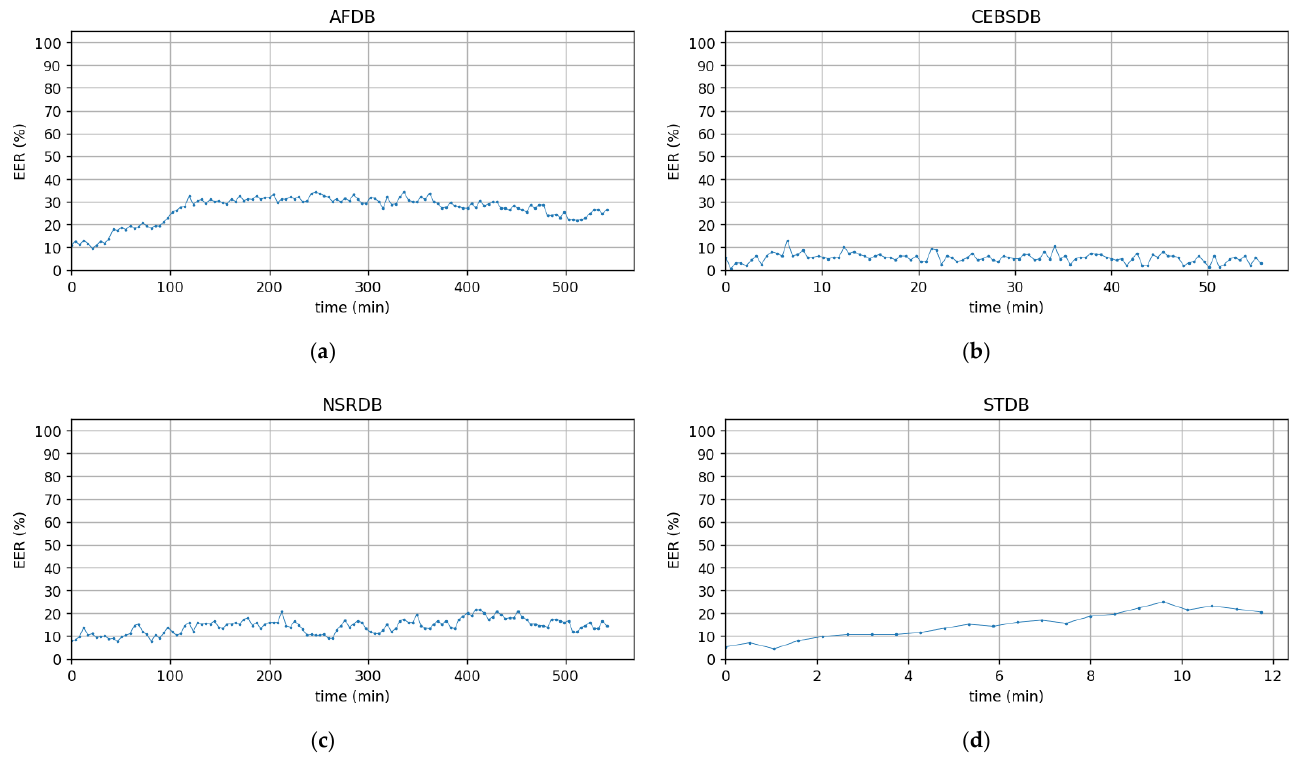
Figure A9. EER of scope verification is plotted against time separation for: ( a ) AFDB, ( b ) CEBSDB, ( c ) NSRDB, ( d ) STDB.